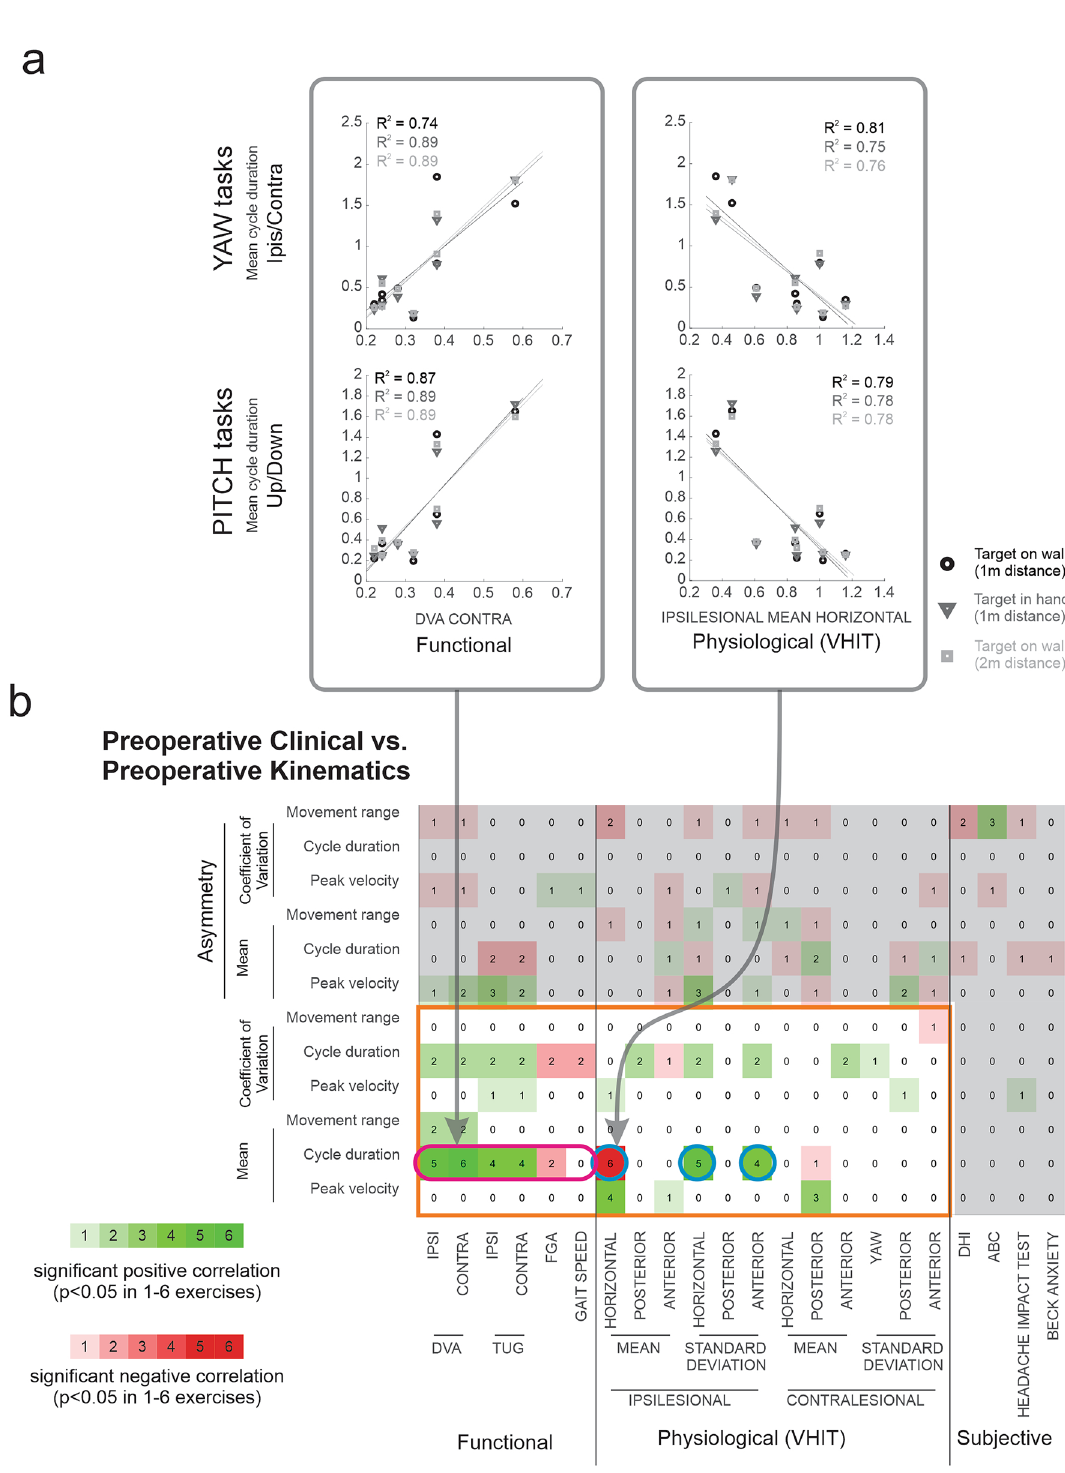
Figure 4. ( a ) Scatter plots showing the correlation between cycle duration and contralesional DVA score (left panel) and between cycle duration and ipsilesional horizontal semicircular canal VOR gain (right panel) in all the 6 exercises. ( b ) Correlations between pre-surgery kinematic measurements and pre-surgery clinical measurements. Green squares indicate positive correlations and red squares indicate negative correlations. Brightness and number in the square indicate the number of exercises (1–6) showing a significant correlation (p <